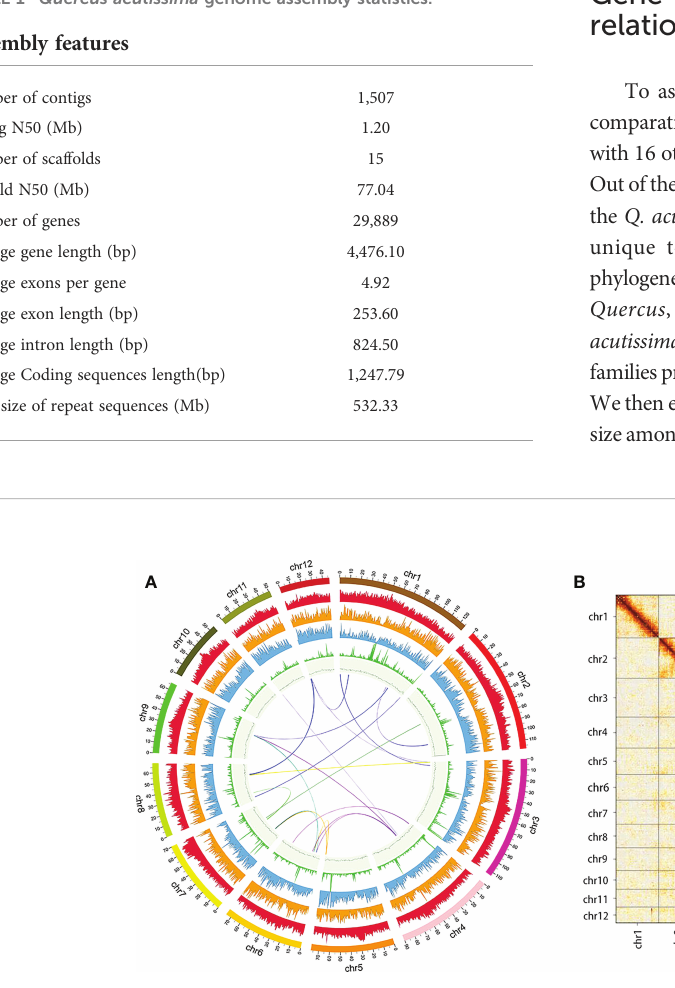
FIGURE 1 Q. acutissima genome features. (A) The genome circle plot (from the outer circle to the inner one, Class I transposable element (TE) density, Class II TE density, coding gene density, tandem repeat percentage, guanine-cytosine (GC) content, and co-linear block, respectively). (B) Twelve pseudo-molecules scaffolding with Hi-C data.